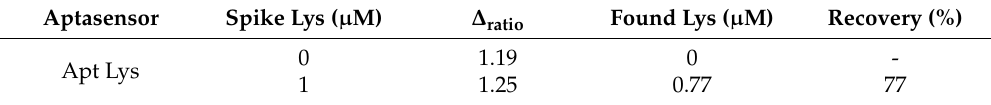
Table 1. Recoveries of Lys in wine samples of aptasensors in real matrix such as